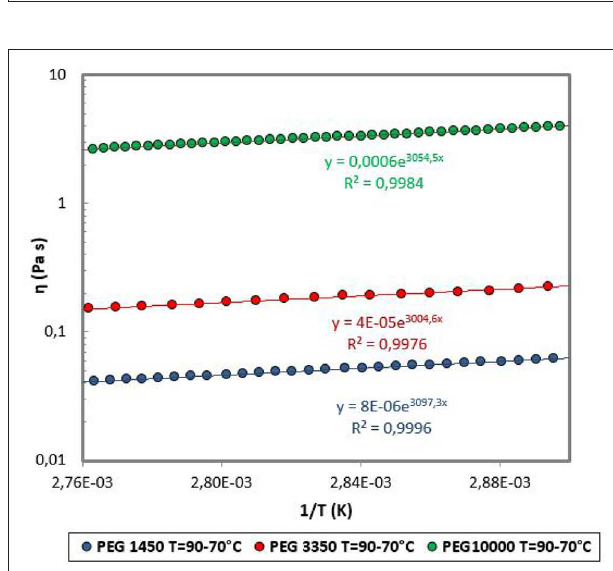
FIGURE 4 | Viscosity as a function of 1/T for PEGs.